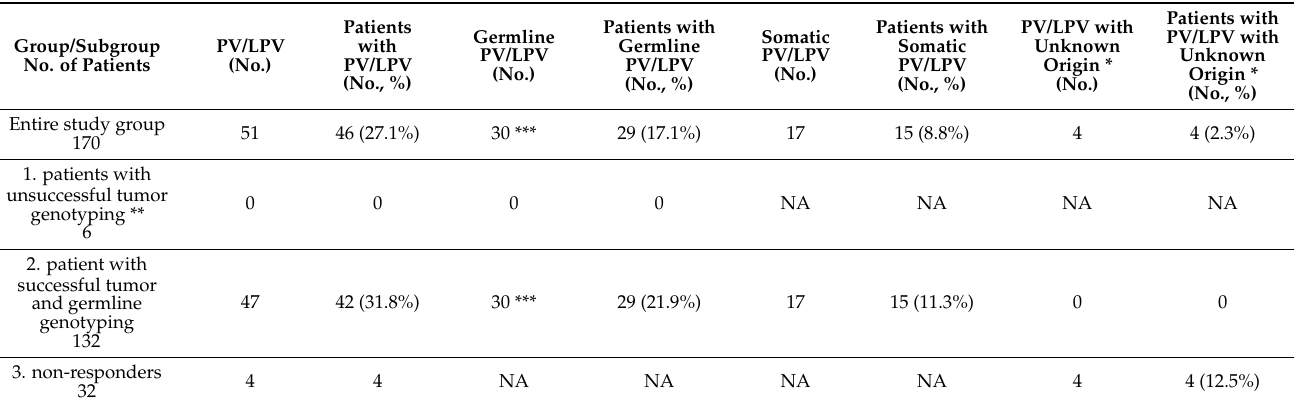
Table 1. Pathogenic/likely pathogenic variants (PV/LPV) in HBOC genes among all 170 consecutive advanced non-mucinous EOC patients.